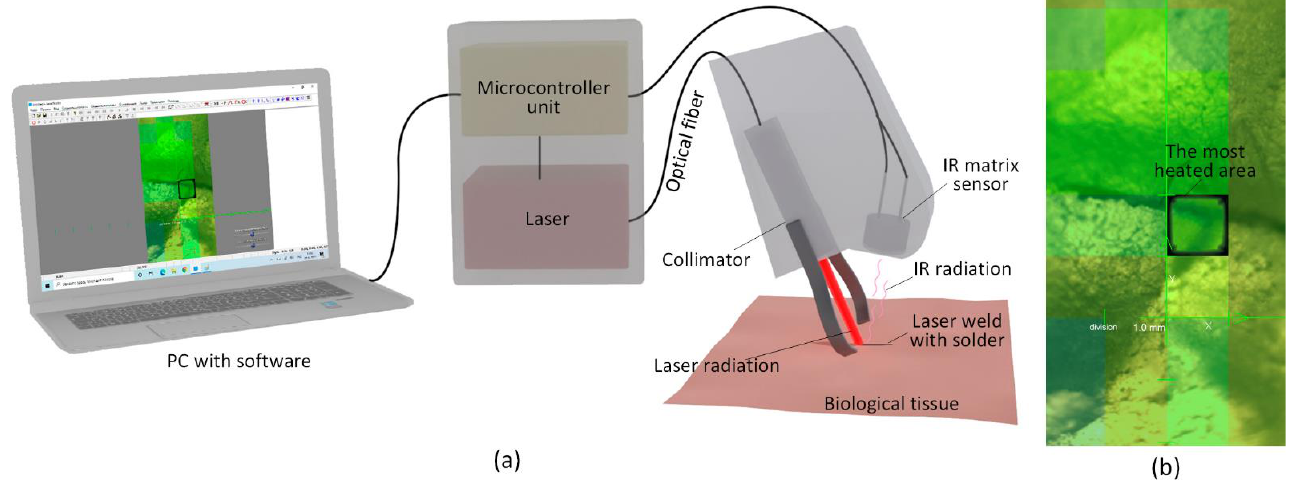
Figure 1. Schematic representation of a soft-tissue laser soldering system ( a ), display with temperature distribution over the area exposed to laser radiation in the software ( b ).